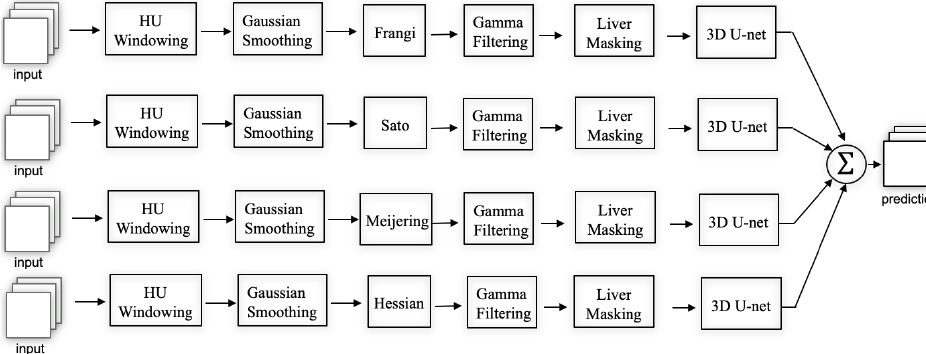
Figure 6. Workflow of the combined prediction from different vesselness filters